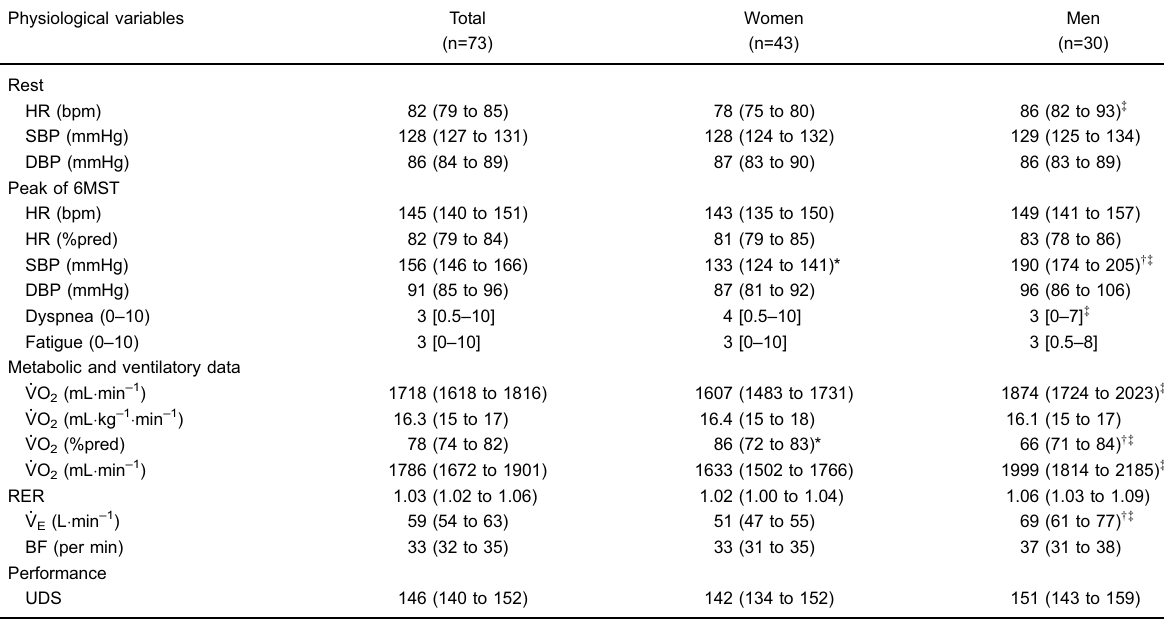
Table 2. Metabolic, ventilatory, and performance variables at rest and at the peak of the 6MST. Physiological